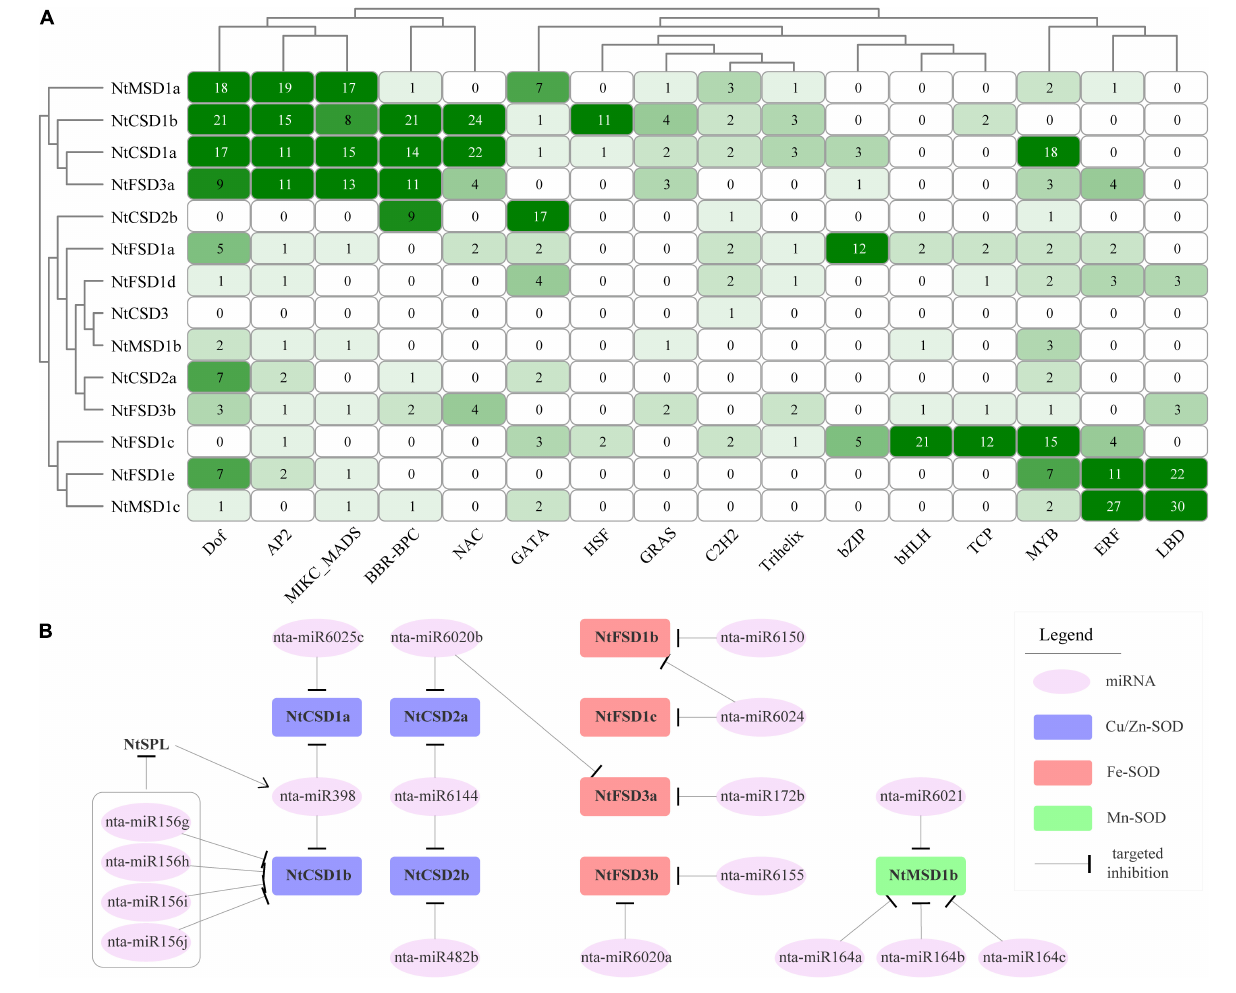
FIGURE 5 | Predicted factors regulating the expression of NtSOD genes. (A) Transcription factor binding sites in the promoters of NtSOD genes. The frequencies of cis -acting elements are represented by numbers and different colors of shading. (B) The predicted miRNAs regulating the expression of NtSOD